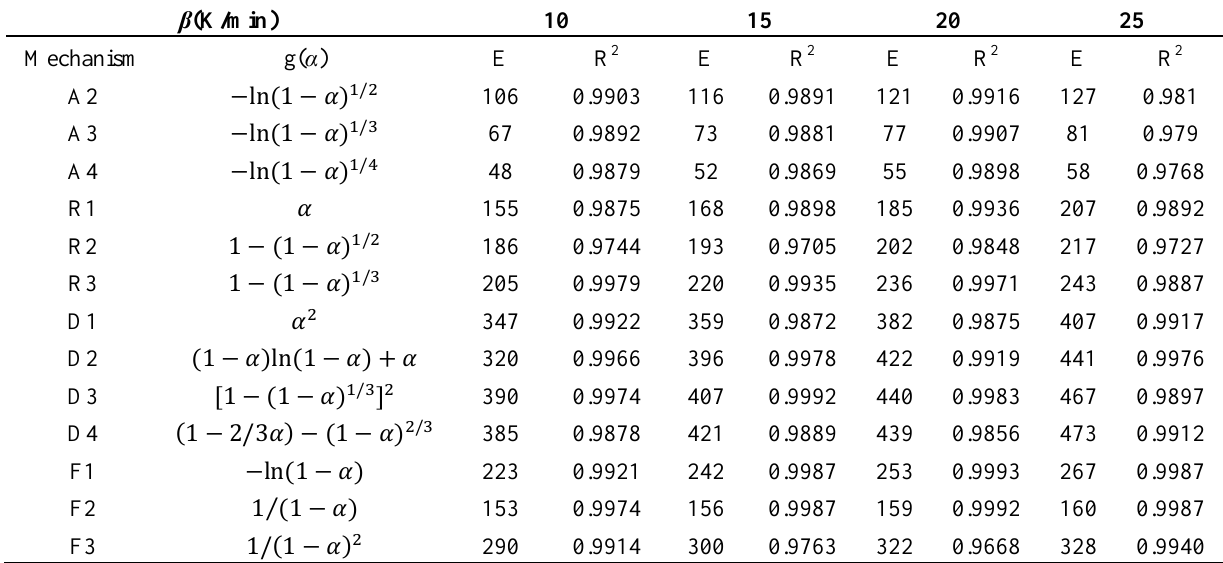
Table 3. Algebraic expressions for g ( α ) for the most used mechanisms and activation energies obtained using the Coats–Redfern